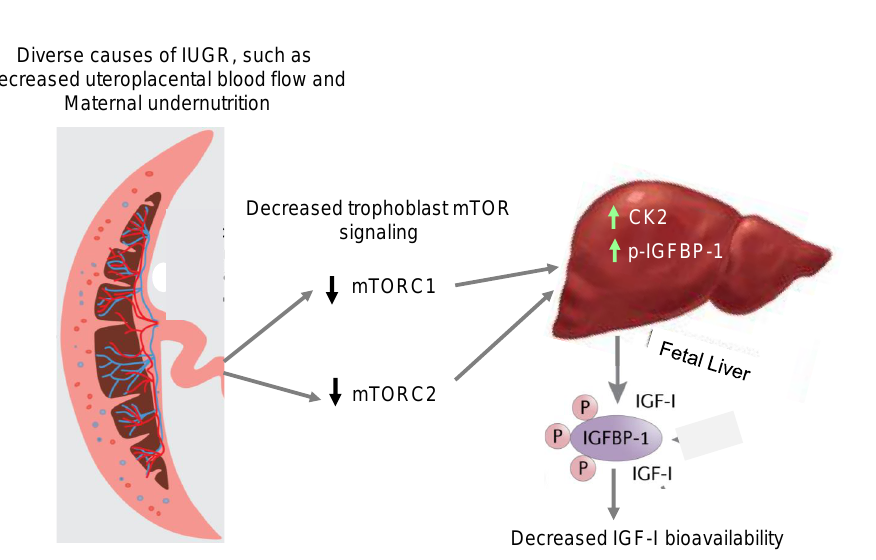
Figure 10. The proposed model of placental mTOR signaling directly influences the endocrine and metabolic function of fetal tissues. Specifically, the bioavailability of IGF-1 is mediated by signals released into fetal